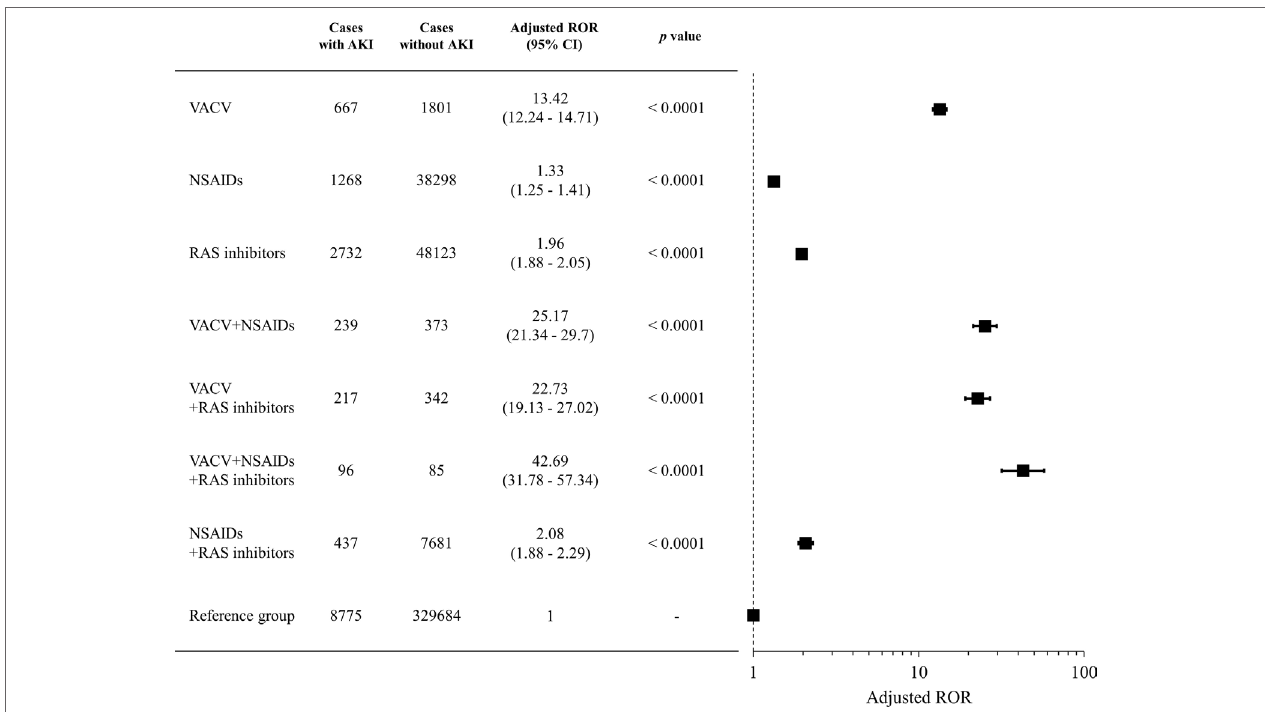
FIGURE 3 | Signals of VACV-related AKI with concomitant use of RAS inhibitors and NSAIDs. Boxes represent reporting odds ratio (ROR), and vertical lines represent 95% confidence interval. RORs were adjusted for age, sex, and reporting